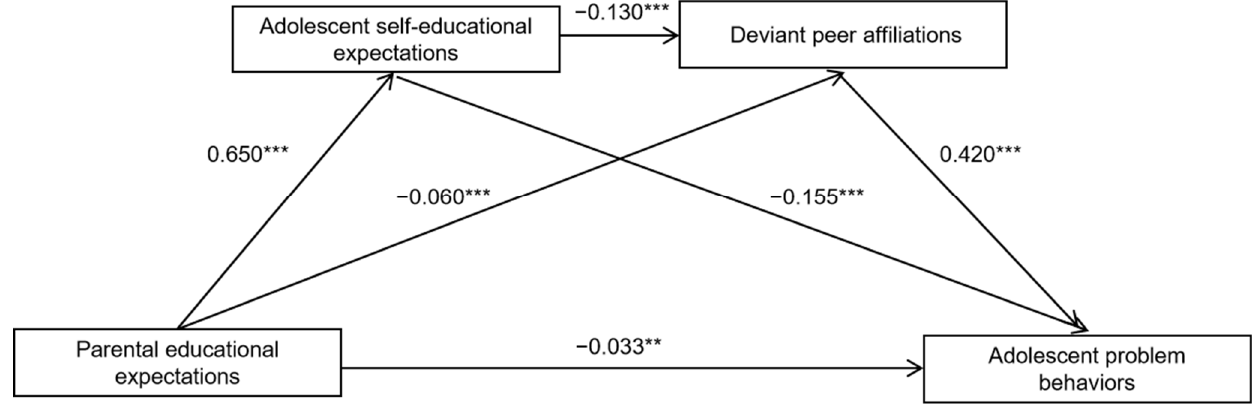
Figure 2. The paths of the multiple mediations. ** p < 0.01, *** p < 0.001